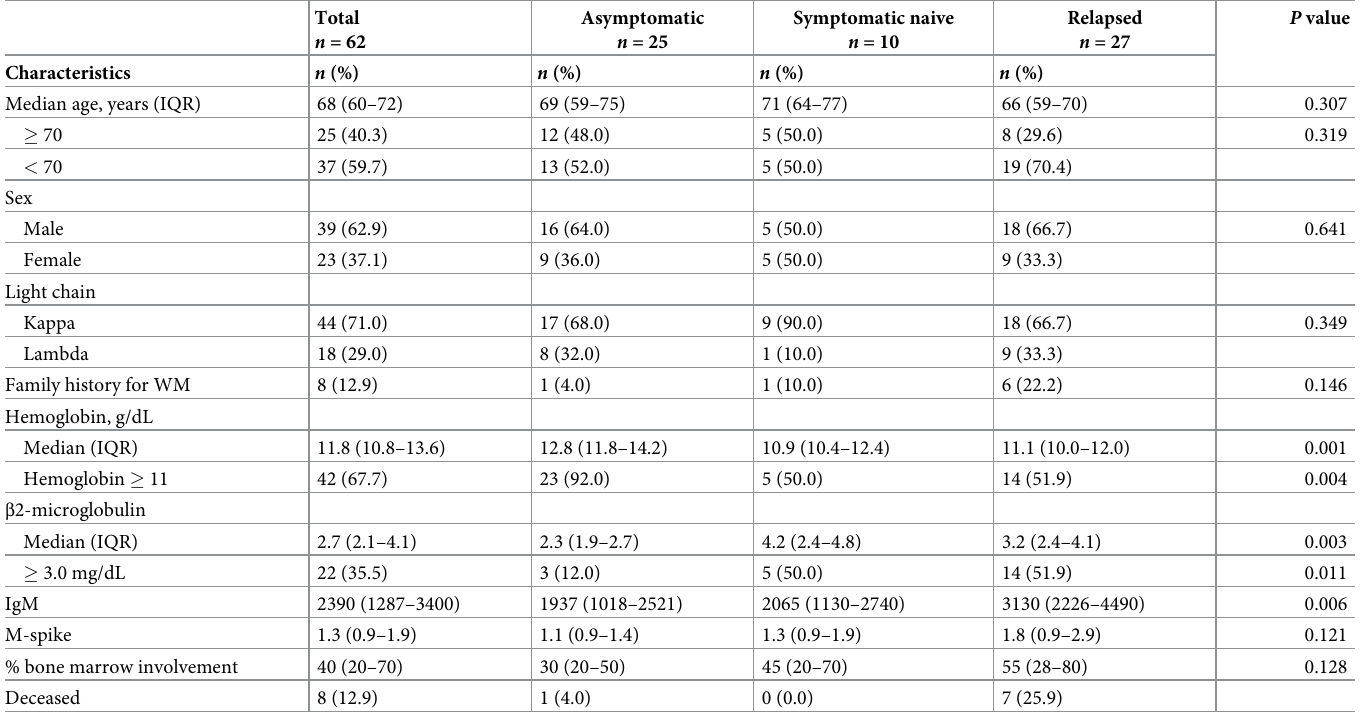
Table 2. Clinical characteristics of Waldenstro¨m Macroglobulinemia patients–Firefly Multiplex circulating miRNA